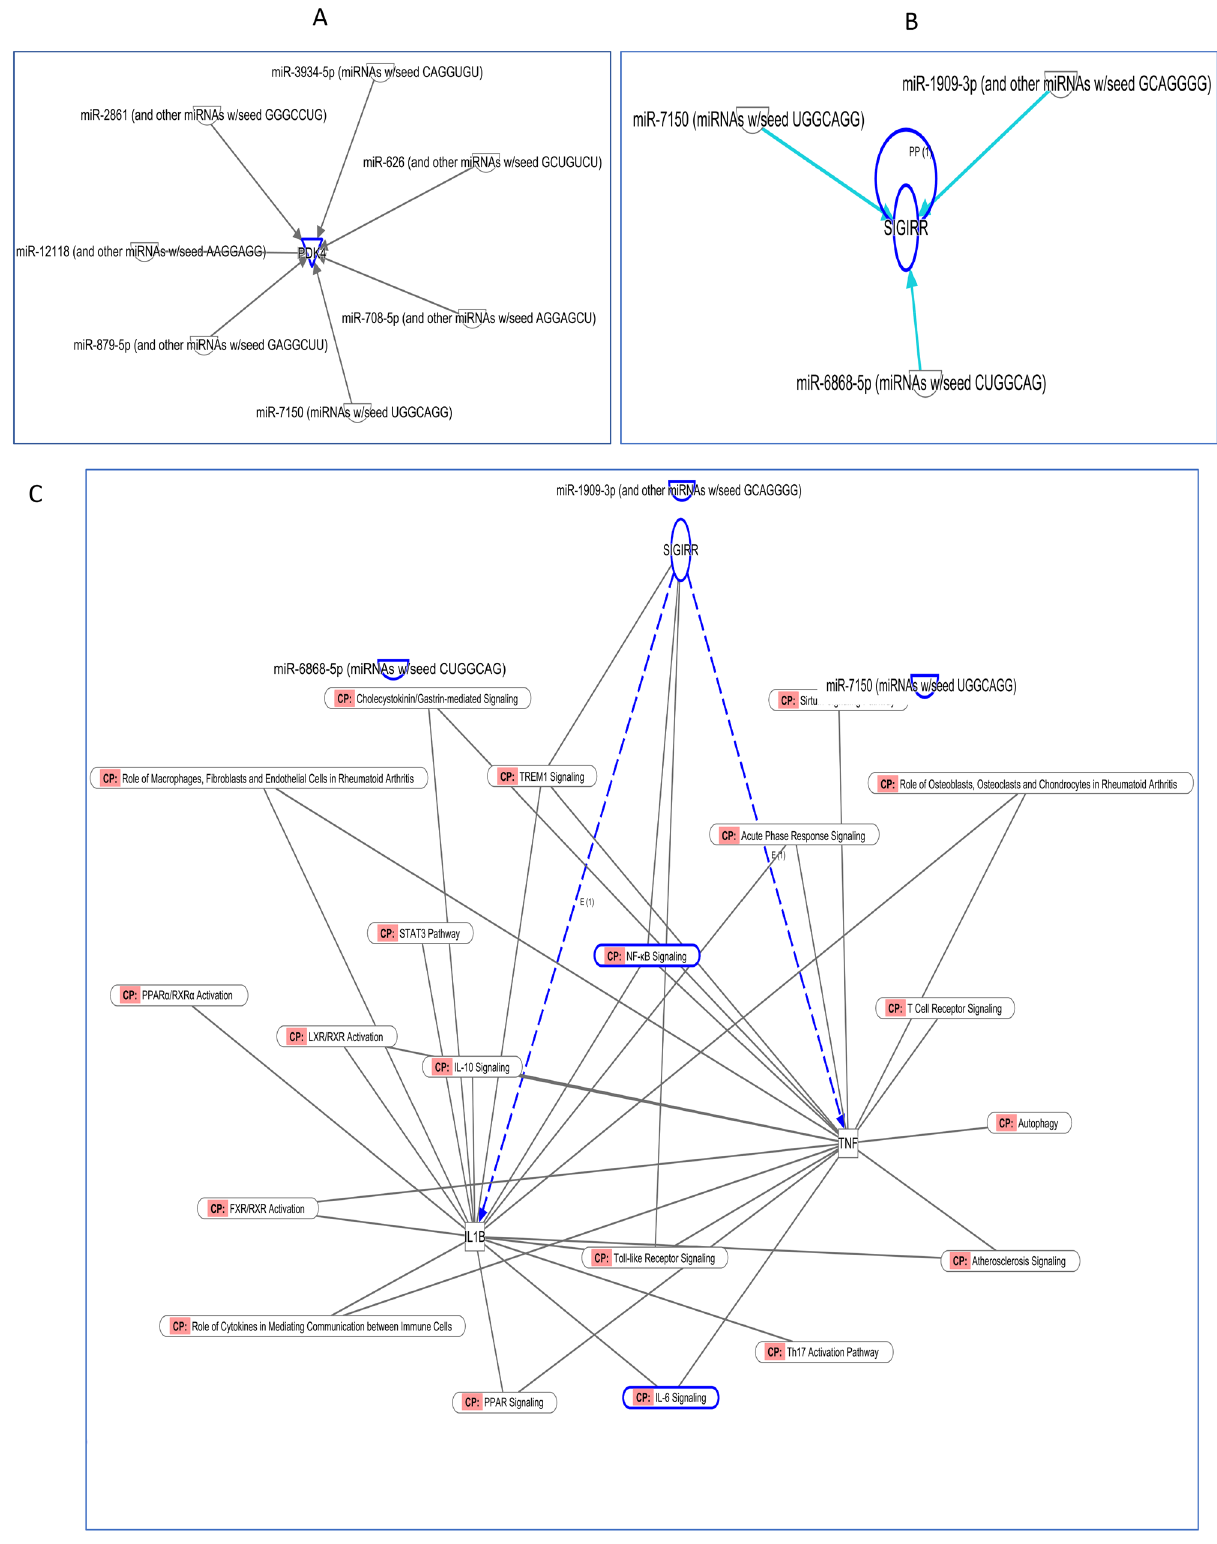
Figure 5. miRNAs targeted PDK4 and SIGIRR is downstream for miRNAs and upstream of metabolic and inflammatory pathways. ( A ) PDK4 mRNA is a target for miR-3173, miR-2861, miR-626, miR-28, miR-7150, miR-3188, miR-3934, and miR-1909. ( B ) SIGIRR mRNA is a target for miR-1909-3P, miR-7150, miR-6868-5P and (other miRNAs with seed GCA GGG G) targeted SIGIRR mRNA. ( C ) SIGIRR upstream for many signalling pathways involved in regulation of transcription factors, inflammatory cytokines, and metabolic molecules. It negatively regulates NF-κB Signalling, TLR signalling, and TREM1 signalling. CP Canonical